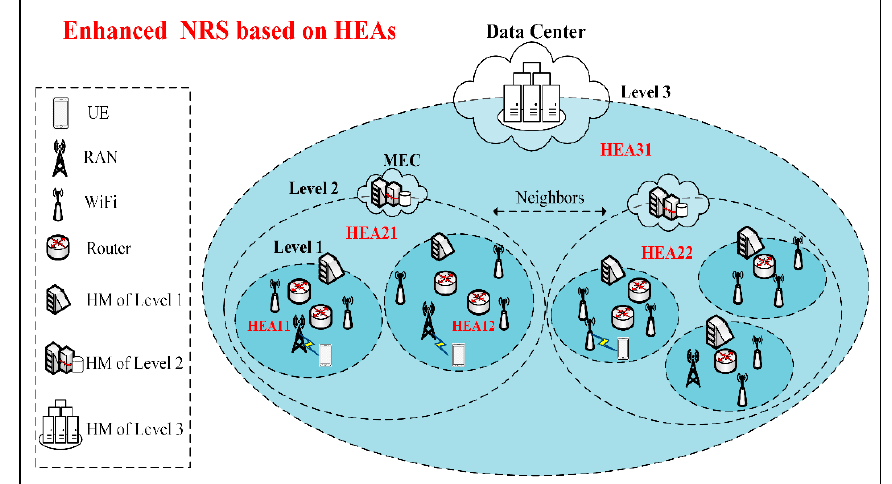
Figure 1. The system model of the Enhanced Name Resolution System ( ENRS).